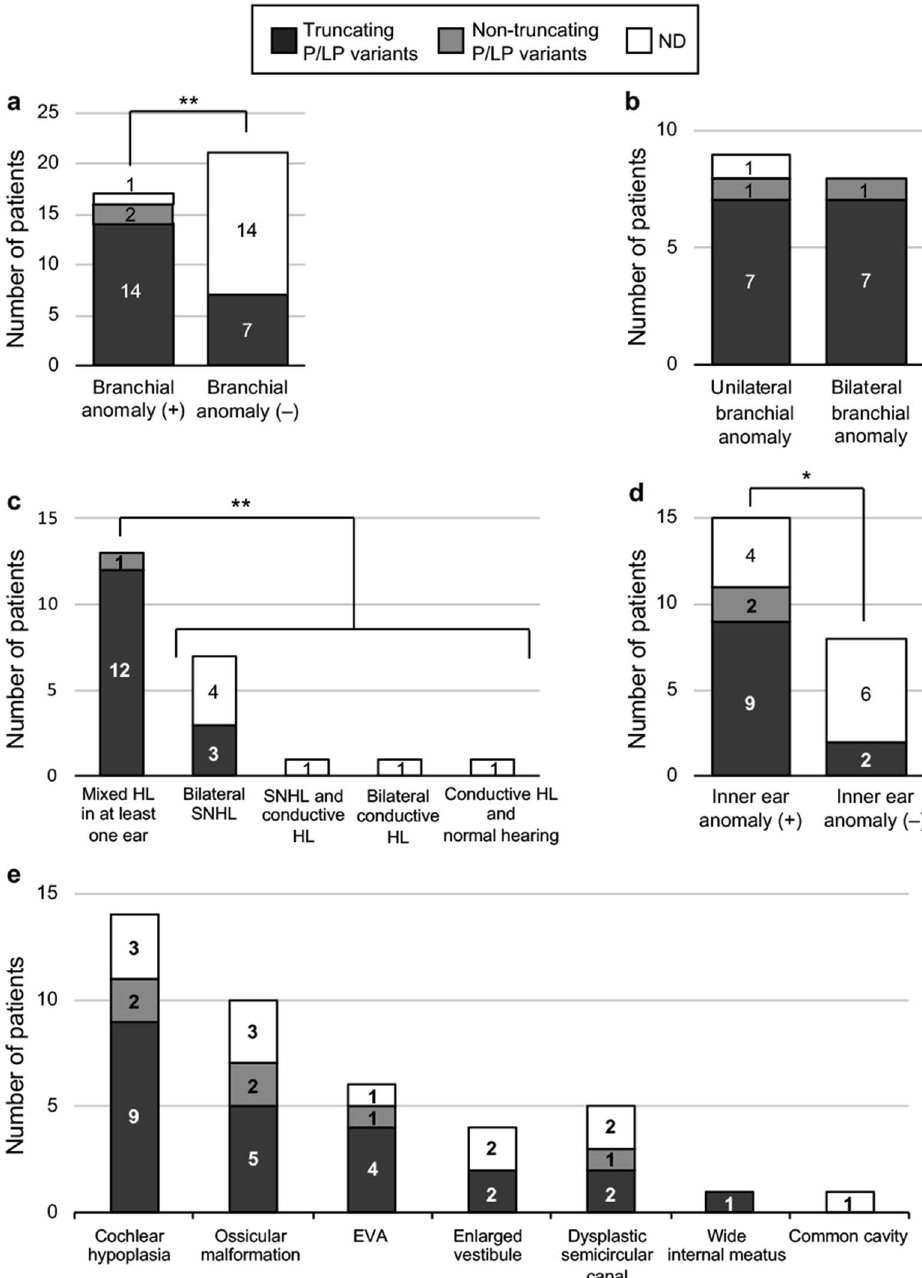
Figure 5. Relationship of P/LP variants with phenotypes. ( a ) Association of branchial anomaly with P/LP variants. ( b ) Relationship between P/LP variants and unilateral or bilateral branchial anomaly. ( c ) Association of hearing loss types with P/LP variants. ( d ) Association of inner ear anomalies with P/LP variants. ( e ) Association of ear anomalies with P/LP variants. Significant difference at **p < 0.01 and *p < 0.05, respectively (Fisher’s exact